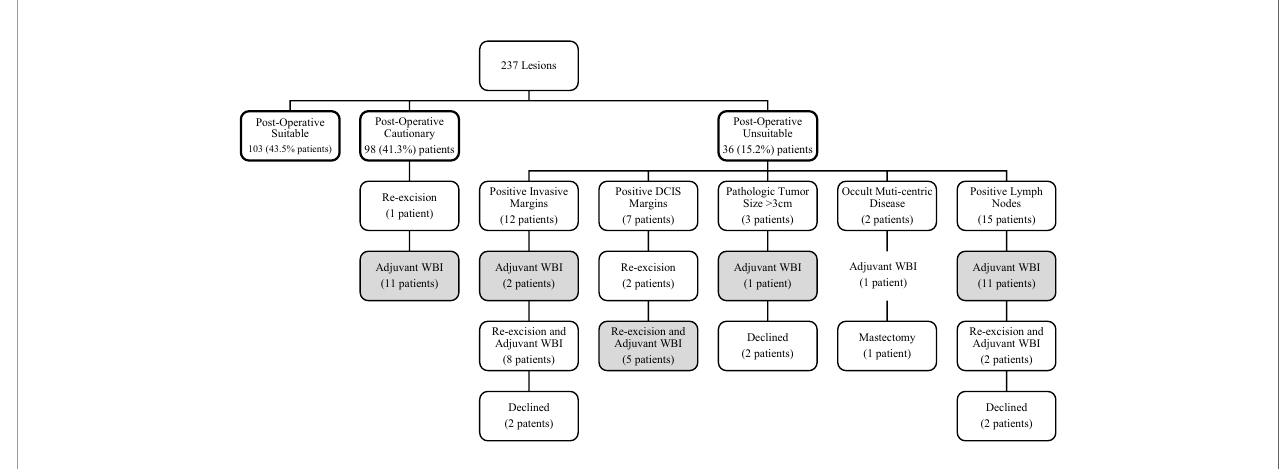
FIGURE 2 | Patient post-operative ASTRO consensus guideline group suitability and